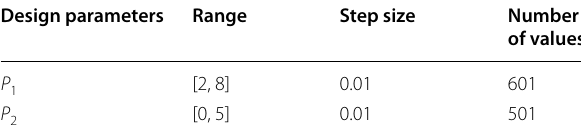
Table 4 Design parameter values of a symmetrical palm Design parameters